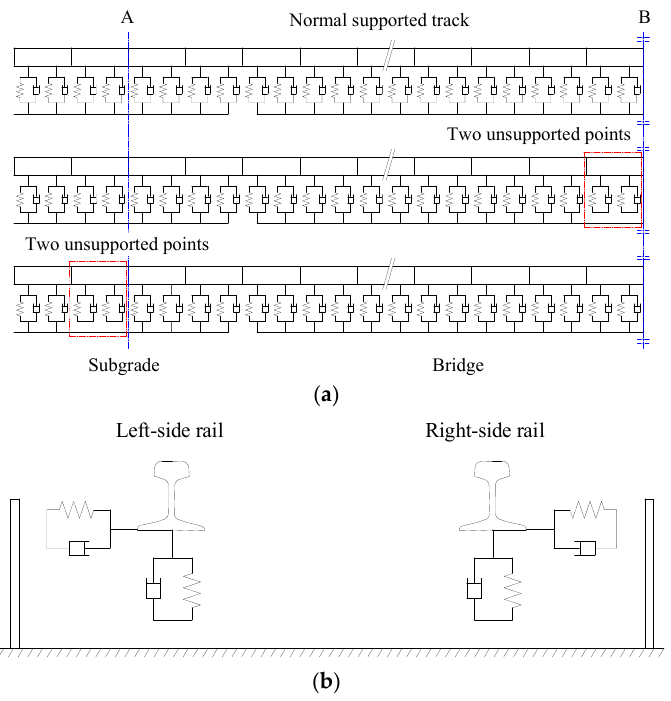
Figure 5. The defect location of the unsupported track on both sides: ( a ) front view and ( b ) lateral view.